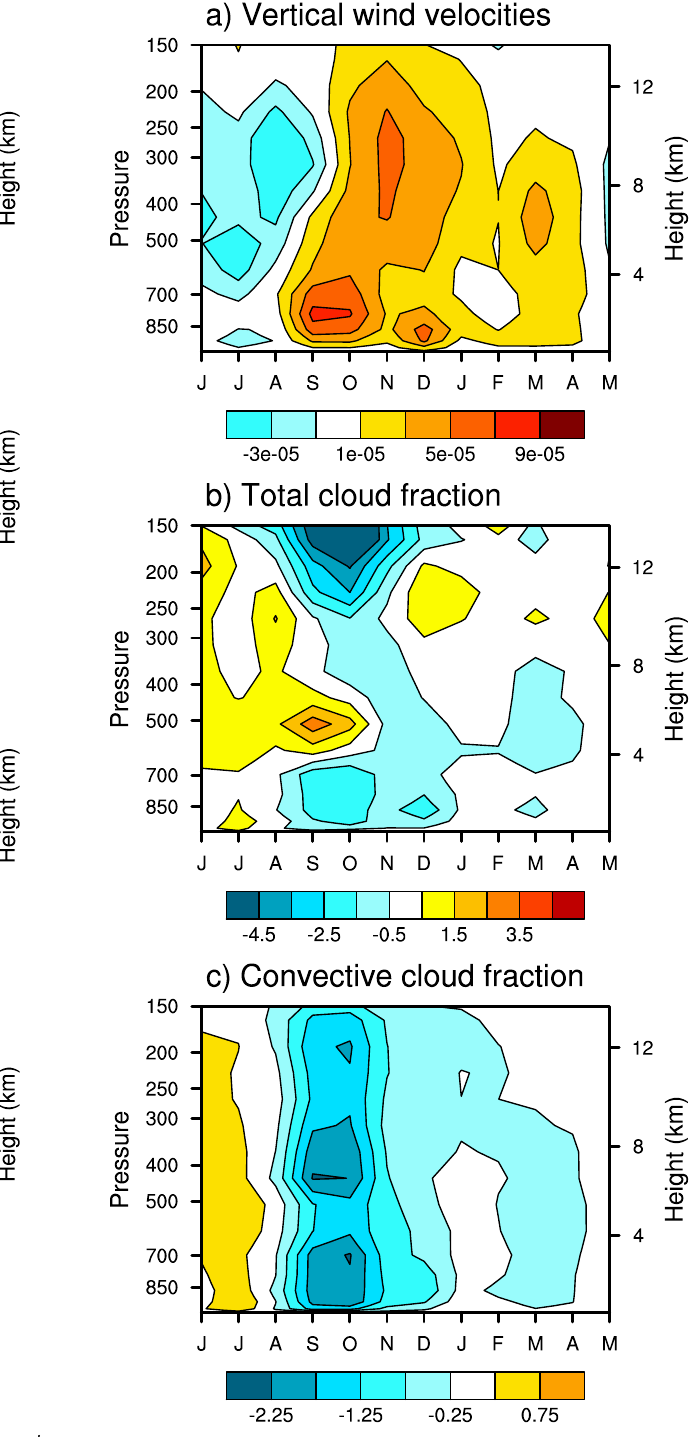
Fig. 7. Simulated fire-induced anomalies in (a) vertical velocity (mbs − 1 ), (b) total cloud cover (%) and (c) convective cloud cover (%). Positive vertical velocity anomalies represent stronger down- drafts. Analysis region is the same as in Fig.